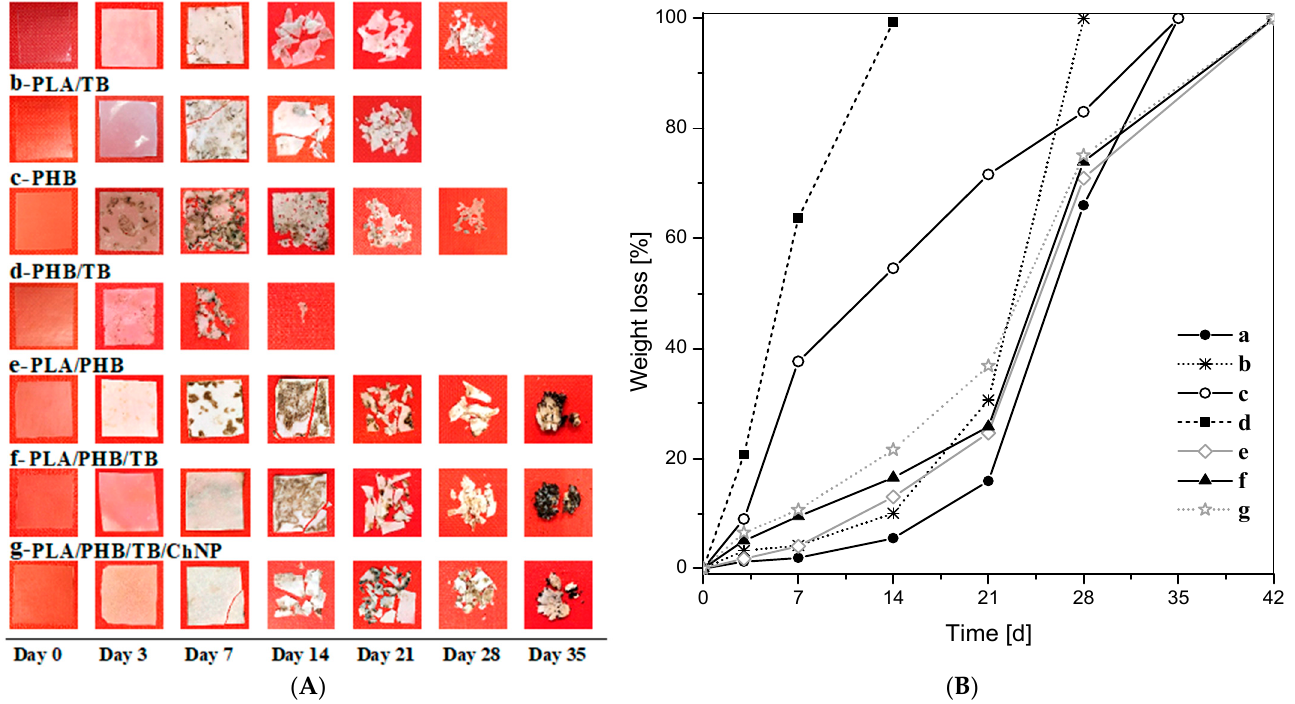
Figure 10. Disintegration under composting conditions before and after different stages of incuba- tion of (a) PLA, (b) PLA/TB, (c) PHB, (d) PHB/TB, (e) PLA/PHB, (f) PLA/PHB/TB, and (g) PLA/PHB/TB/ChNP: ( A ) visual observation and ( B ) disintegrability percentage